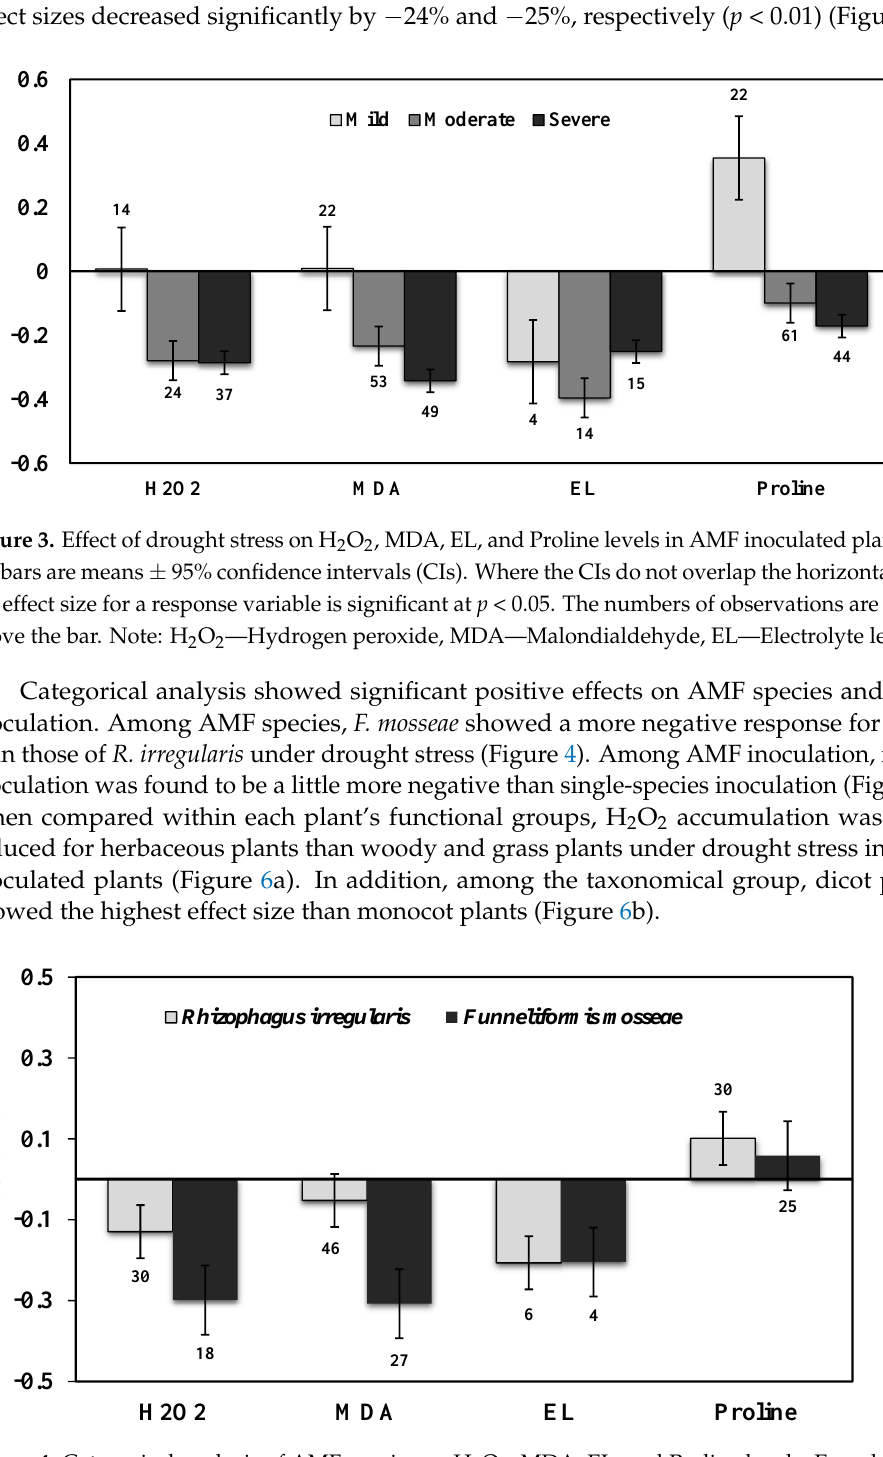
Figure 4. Categorical analysis of AMF species on H 2 O 2 , MDA, EL, and Proline levels. Error bars are means ± 95% confidence intervals (CIs). Where the CIs do not overlap the horizontal lines, the effect size for a response variable is significant at p < 0.05. The numbers of observations are shown above the bar. Note: H 2 O 2 − Hydrogen peroxide, MDA − Malondialdehyde, EL − Electrolyte leakage.